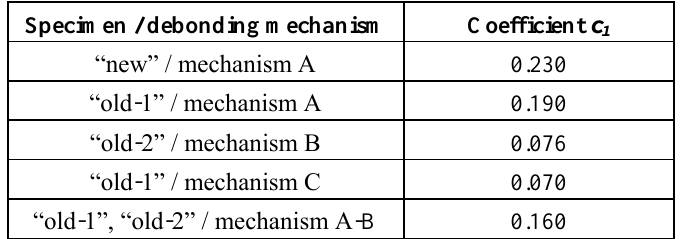
Table 4. Experimental values of the coefficient c1 (Equation